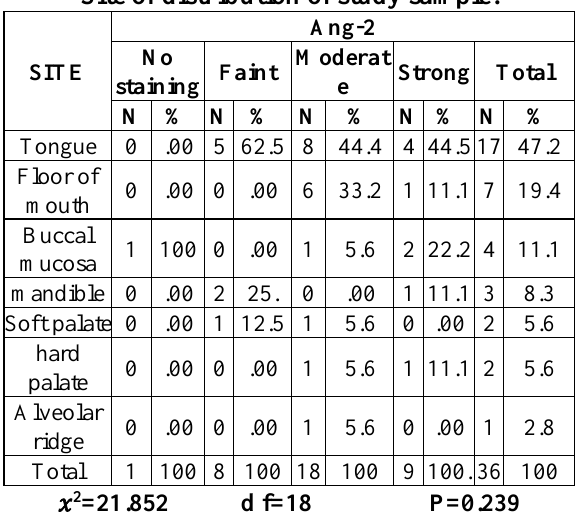
Table 7: Association of Ang-2 expression and Site of distribution of study sample.